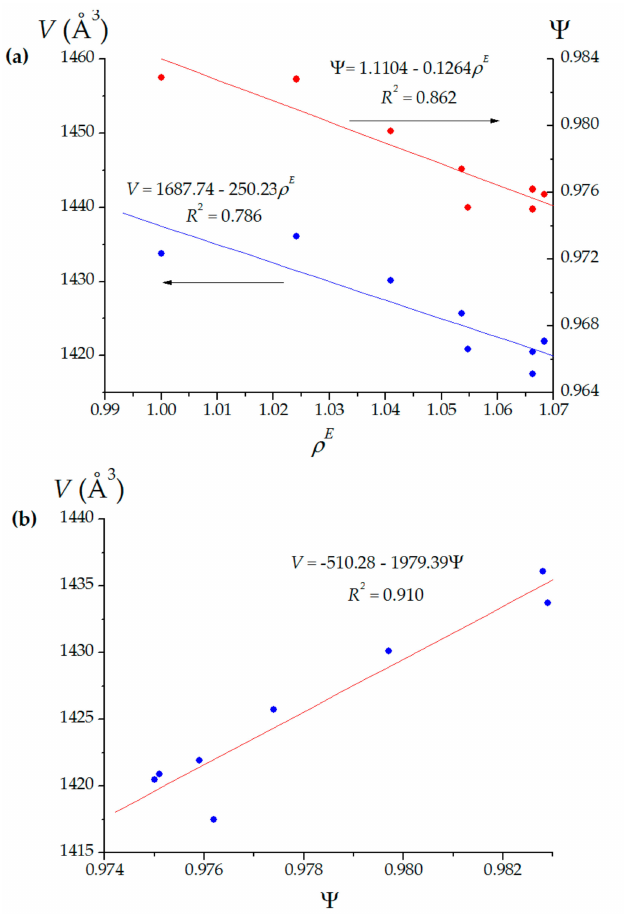
Figure 7. ( a ) Correlations between the extremal roundness, volume and sphericity of the C 240 cages. ( b ) Linear correlation between the volume and sphericity of the C 240